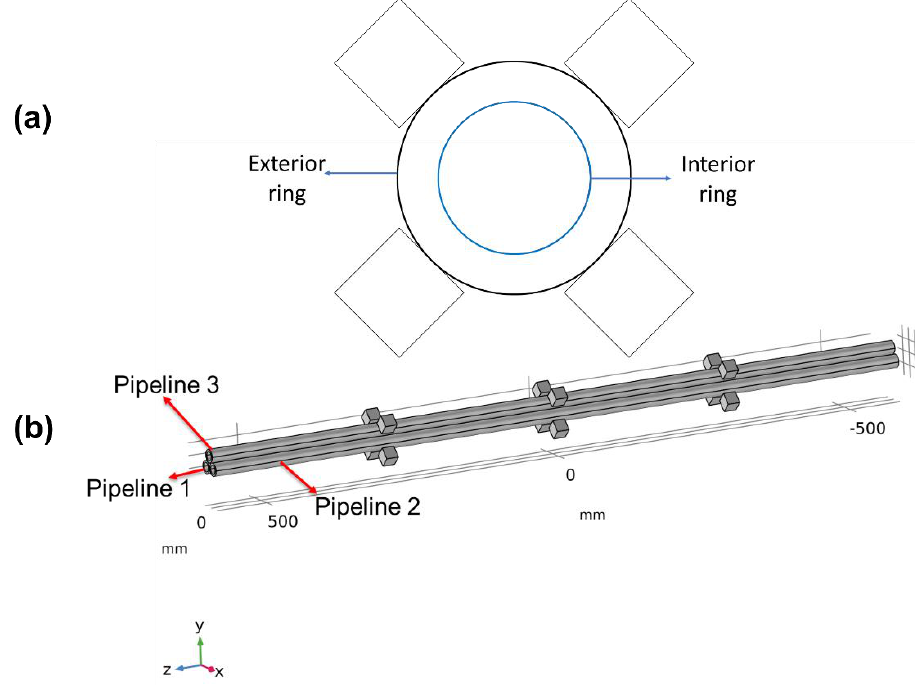
Figure 2. ( a ) Cross section view in the X–Y plane showing two rings where the SMF is evaluated. ( b ) Sketch of the three pipelines surrounded by the magnets. An evaluation line is defined as the symmetry axis of each pipeline and another evaluation line, which is the symmetry axis of the whole system, along the z-coordinate.